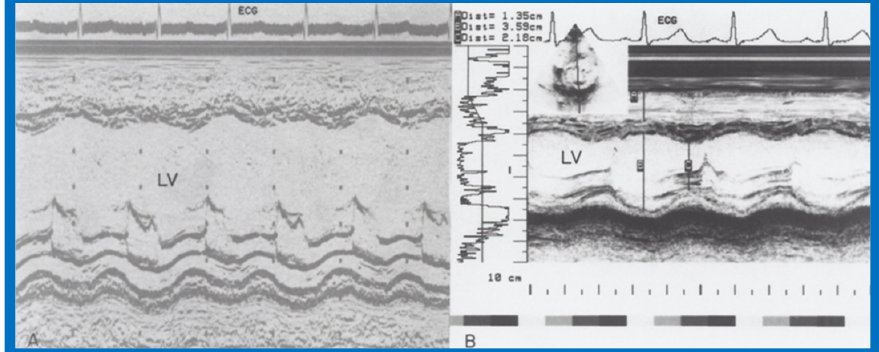
Figure 40. Selected M-mode recording from the parasternal short axis view of the left ventricle (LV) prior to ( A ) and following ( B ) hydrazine therapy. Note the significant improvement in the LV size and function.